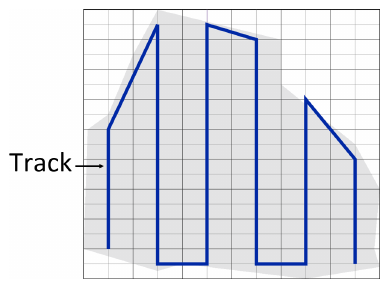
Figure 1. Coverage algorithm proposed in [22] for the area of